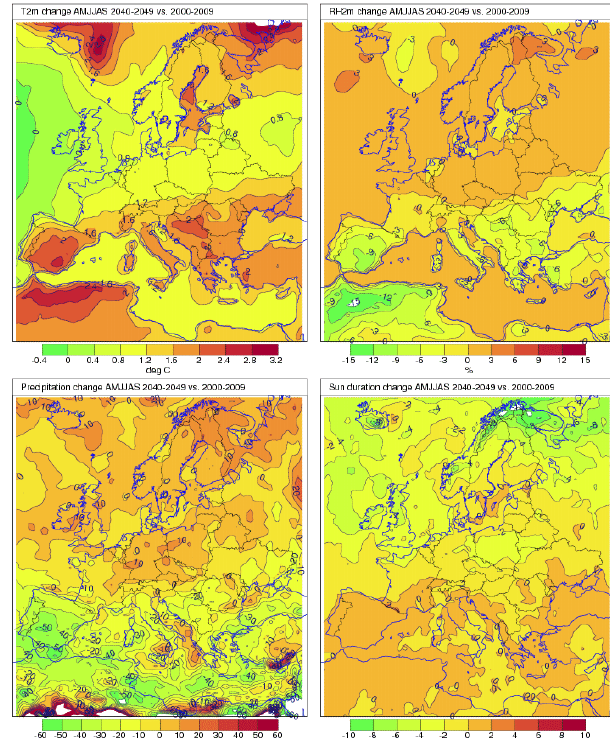
Fig. 2. Simulated April–September change 2000–2009 to 2040– 2049 in two meter temperature, precipitation, sunshine duration and relative humidity at two meter simulated by RCA3. Units ◦ C and